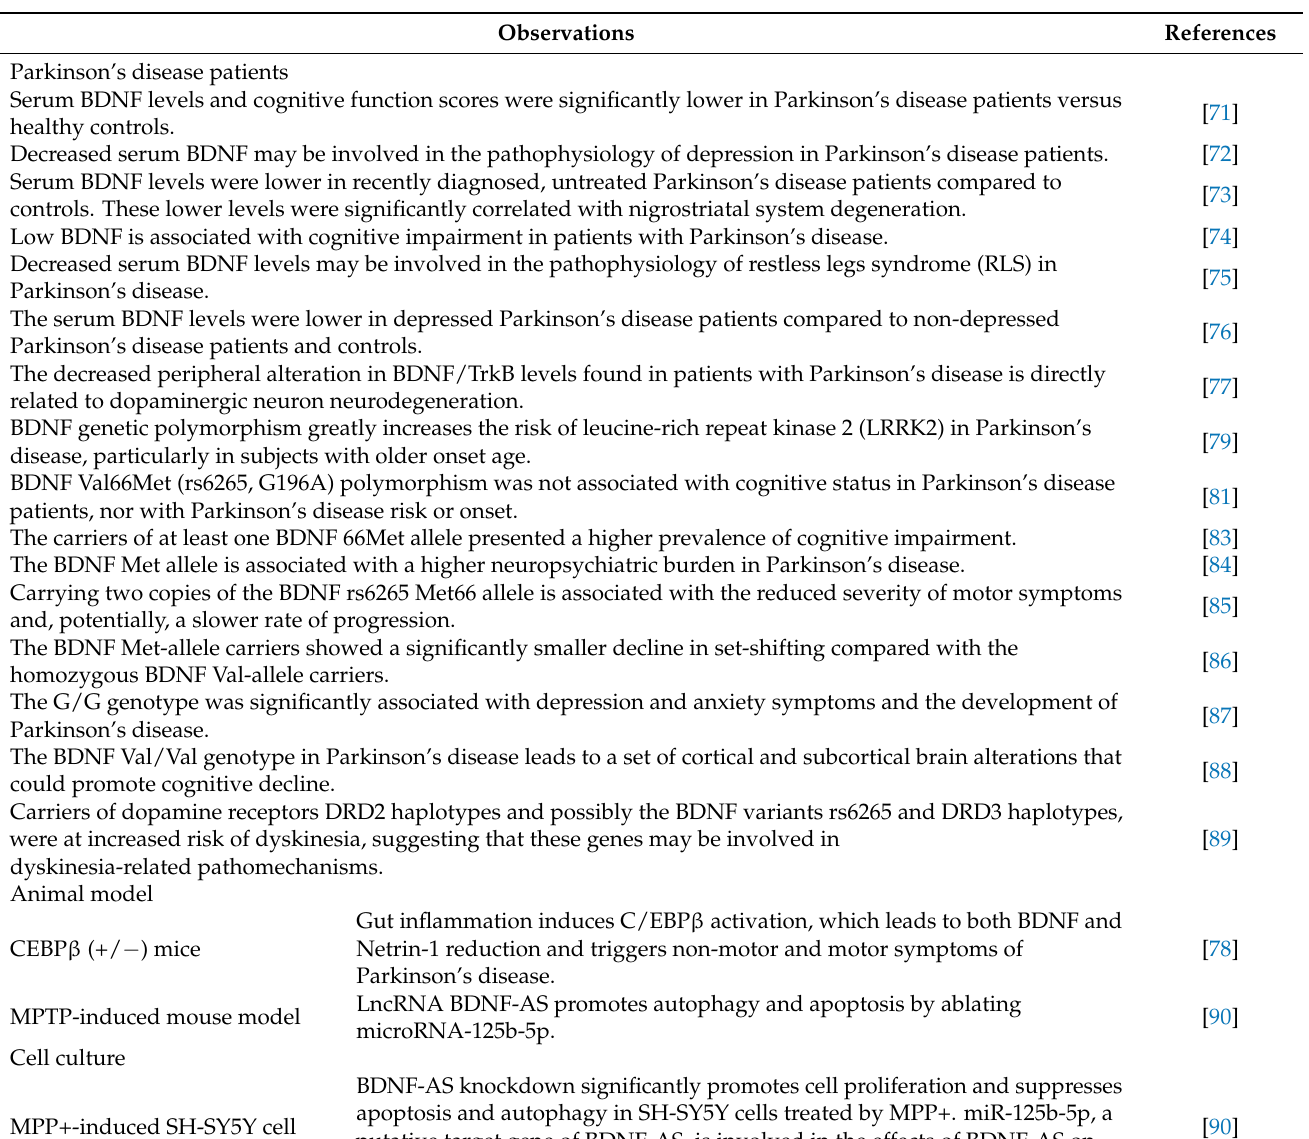
Table 2. Role of BDNF in Parkinson’s